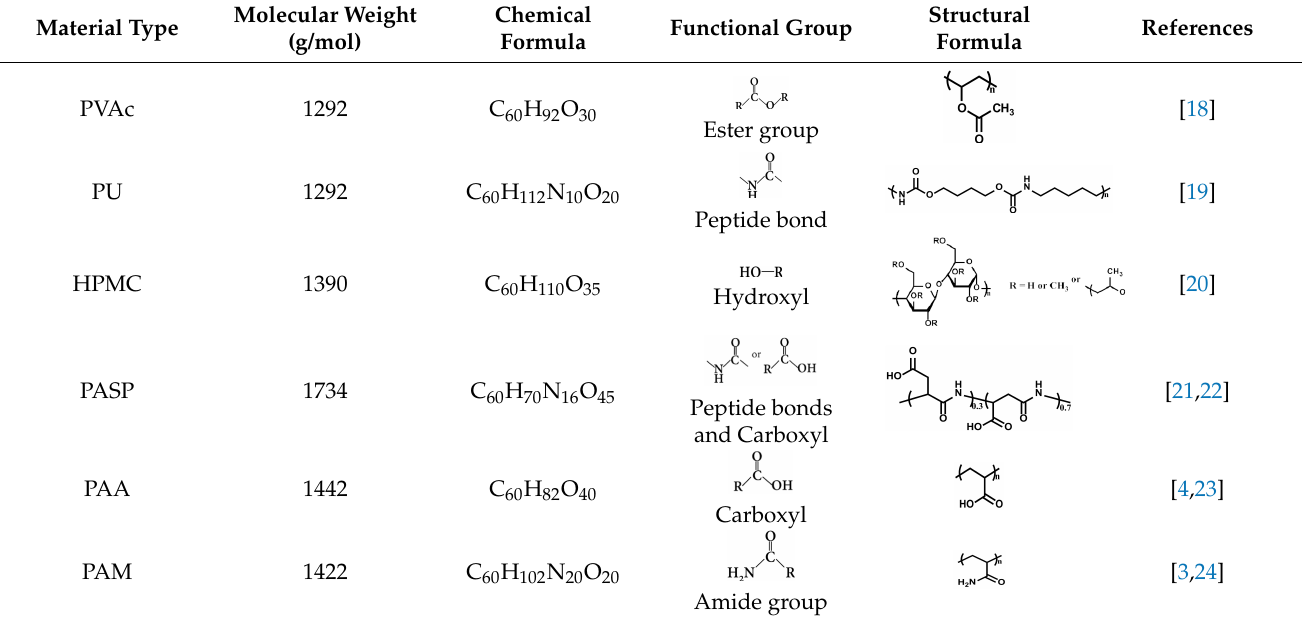
Table 1. Basic properties of sand-fixing agent.